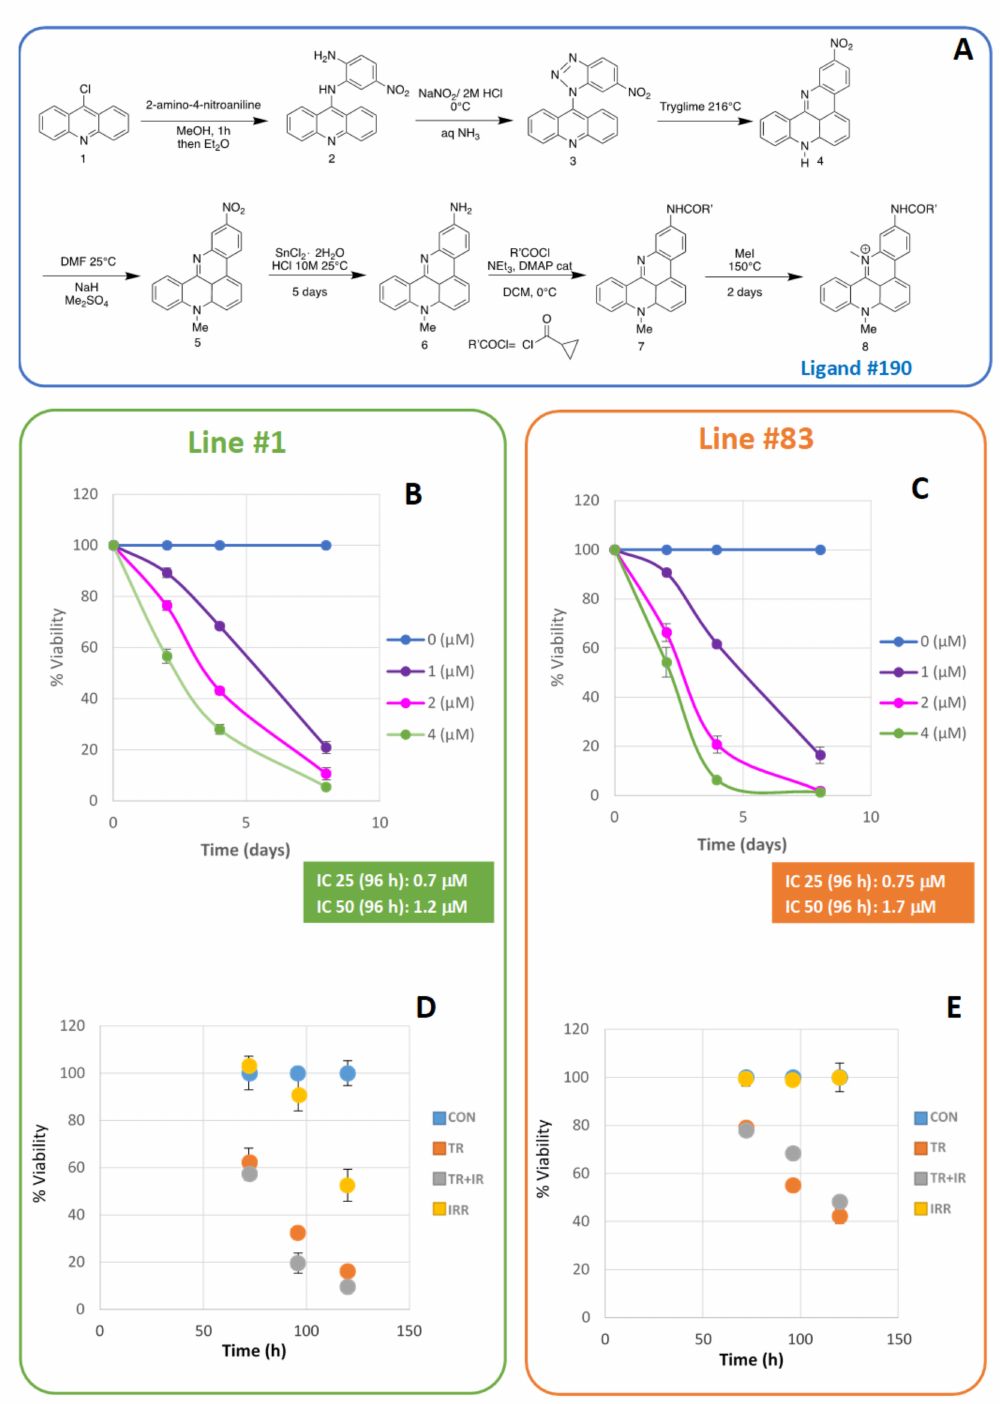
Figure 1. Synthetic protocols followed for the synthesis of target compound 8 , named ligand #190 ( A ). Dose-response curves for line #1 ( B ) and #83 ( C ) after treatment with ligand #190 as a function of time. The values of the extrapolated inhibition concentrations 25% (IC25) and 50% (IC50) at 96 h after treatment are indicated. Line #1 ( D ) and line #83 ( E ) percentage of viability shown as a function of time in the four different conditions (control—CON; ligand #190 treated—TR; photon beam irradiated—IR; and irradiated plus treated—IR +